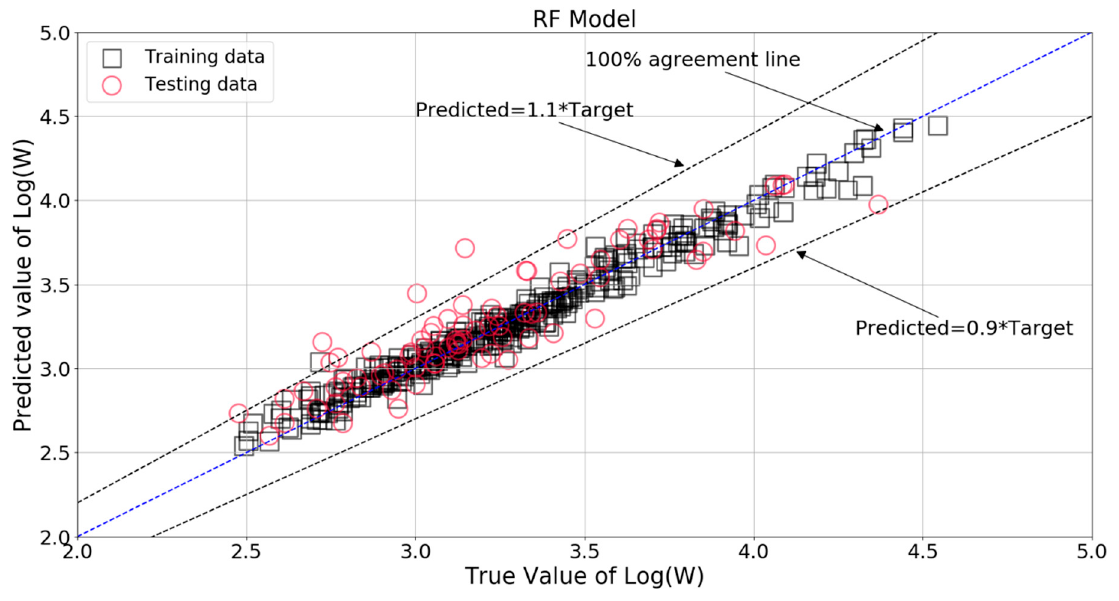
Figure 19. R 2 change curve of the Random Forest (RF) model with parameters min_samples_split and min_samples_leaf.